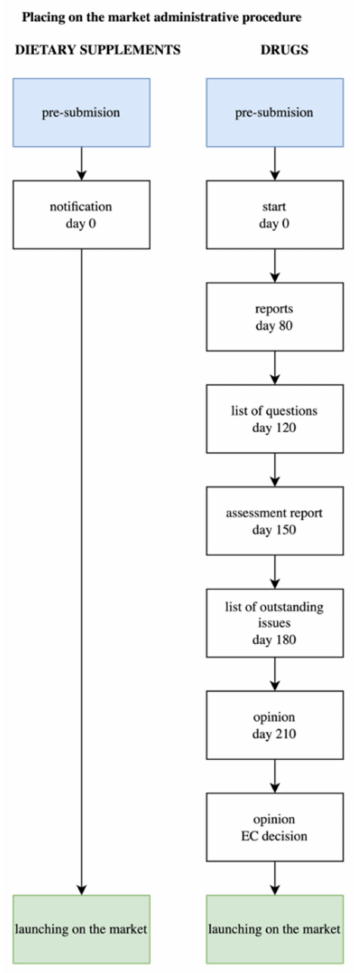
Figure 1. Scheme of the notification procedure of a dietary supplement in Poland in comparison with registering a medicinal product in the “common procedure” mode in the European Union, taking the relevant timeline under